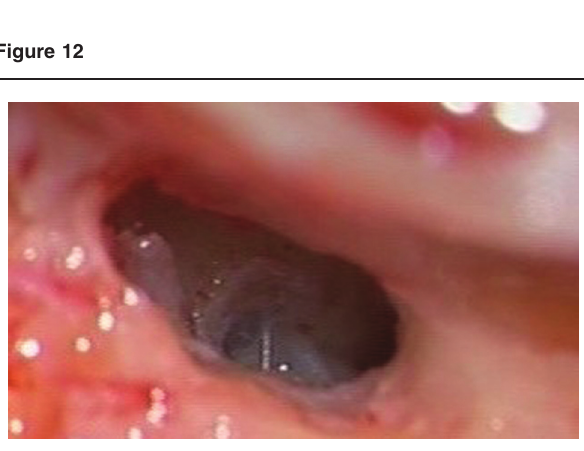
Same patient with RWM exposed after extensive drilling. RWM, round window